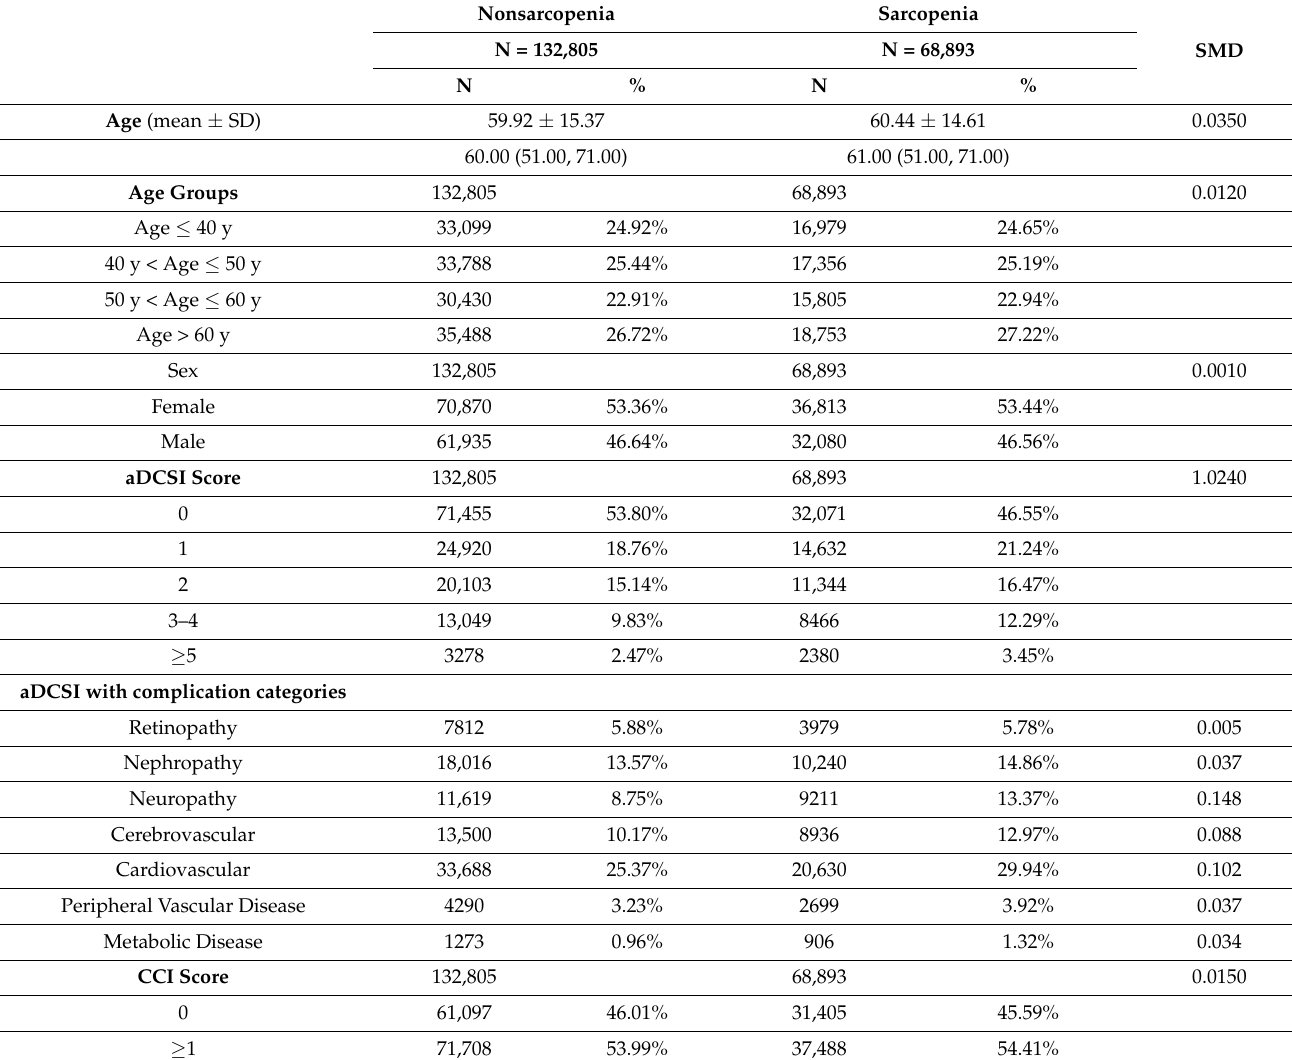
Table 1. Characteristics of patients with diabetes with and without sarcopenia (after propensity score matching at a ratio of